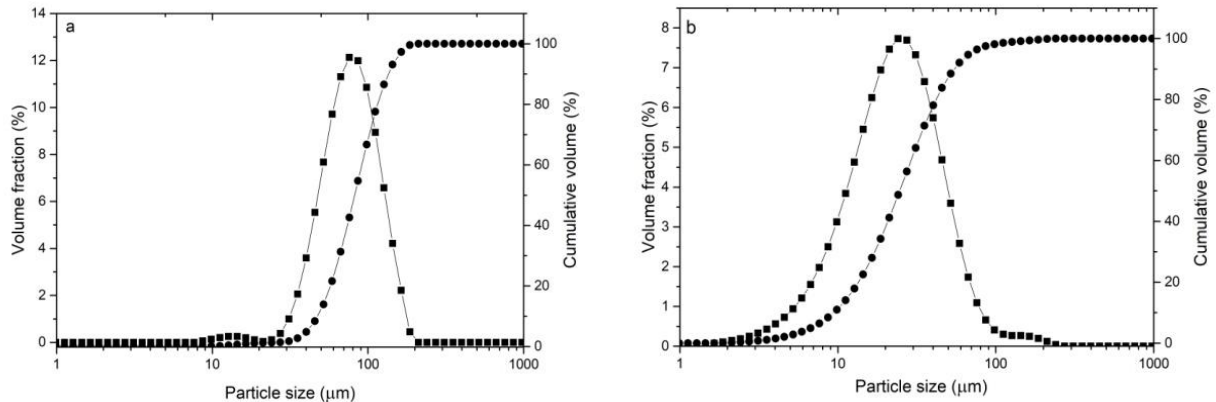
Figure 2. Grain size distribution of powders; ( a ) Ni-25Graphite, ( b ) Cr 3 C 2 -25(Ni20Cr).